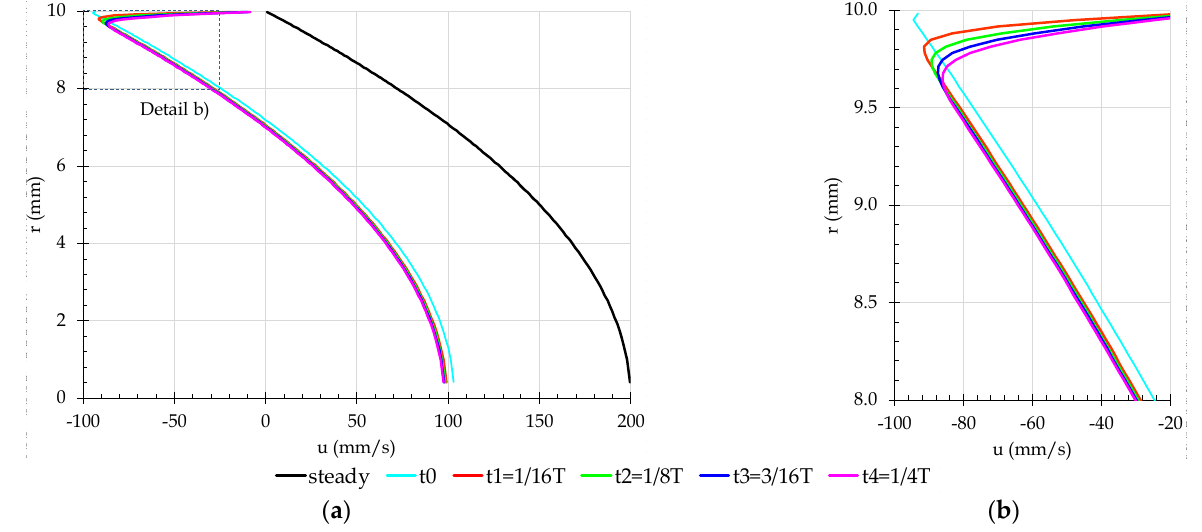
Figure 6. Axial velocity for four instances equally spaced in time during the first pressure wave: ( a ) complete pipe radius, 0 ≤ r (mm) ≤ 10; ( b ) close to the pipe wall, 8 ≤ r (mm) ≤ 10.